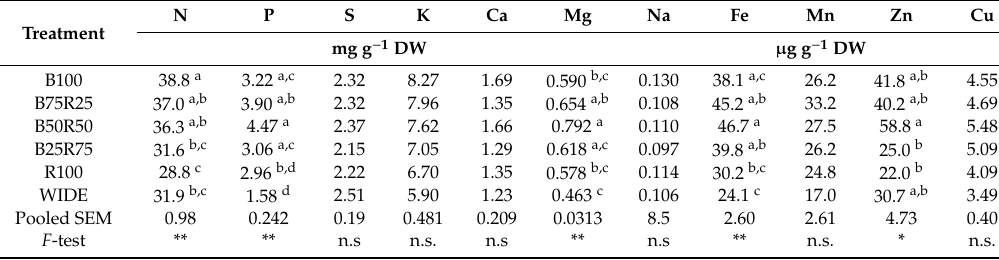
Table 3. Shoot content of mineral elements found in einkorn plants grown under six di ff erent light treatments. Means followed by the same letters are not statistically di ff erent for p < 0.05 (Tukey’s HSD test). SEM: pooled standard error of the mean. * and ** indicate that the values are significantly di ff erent for p < 0.05 and p < 0.01, respectively; n.s. indicates that the values are not significantly di ff